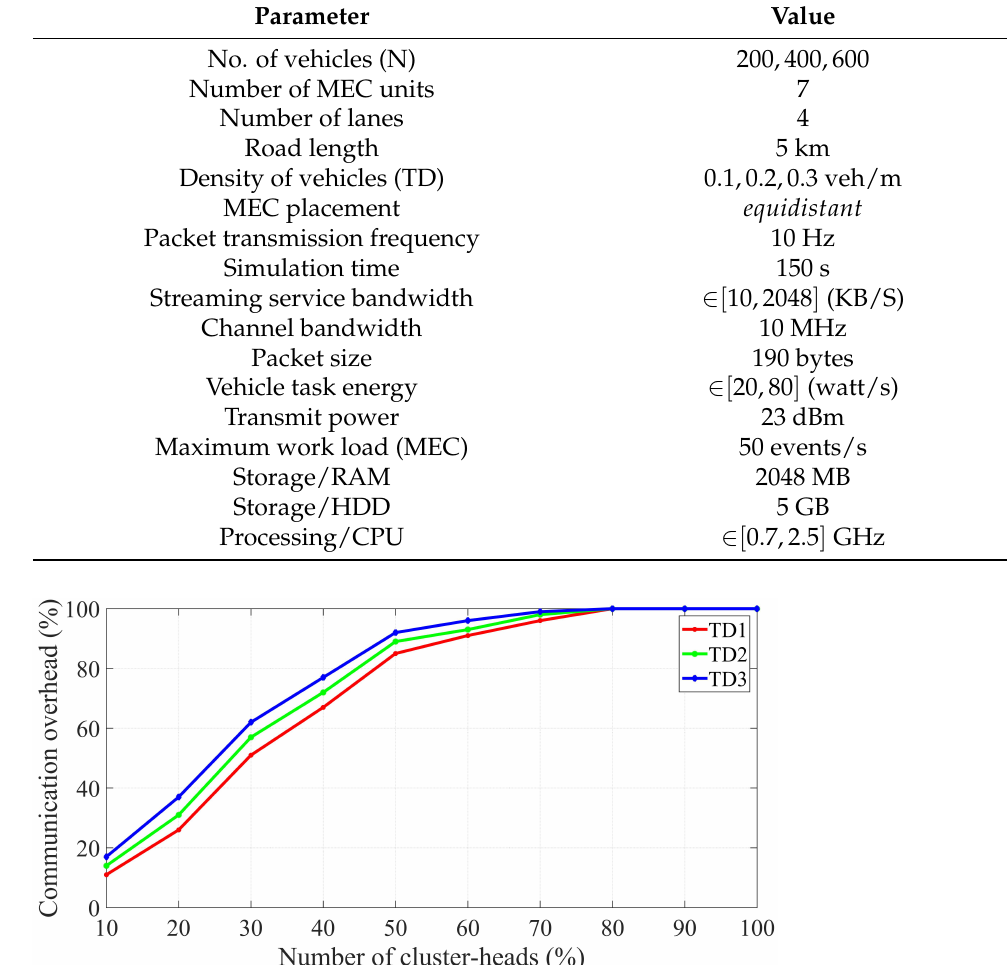
Figure 3. Percentage of the communication overhead with the change in the number of cluster heads, for different values of traffic